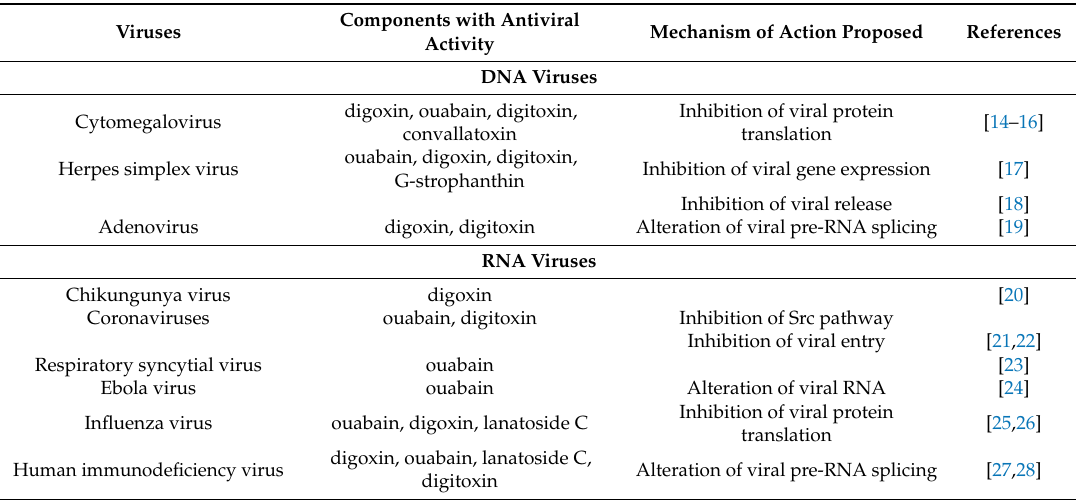
Table 1. Summary of cardiac glicosides with reported antiviral